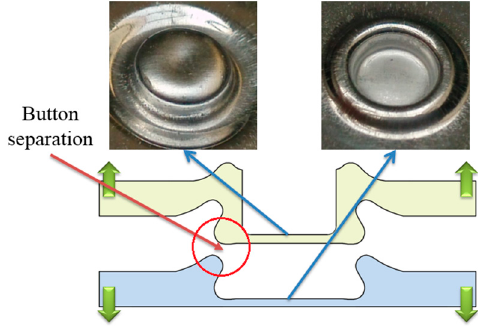
Figure 12. Button separation mode in the tensile test.